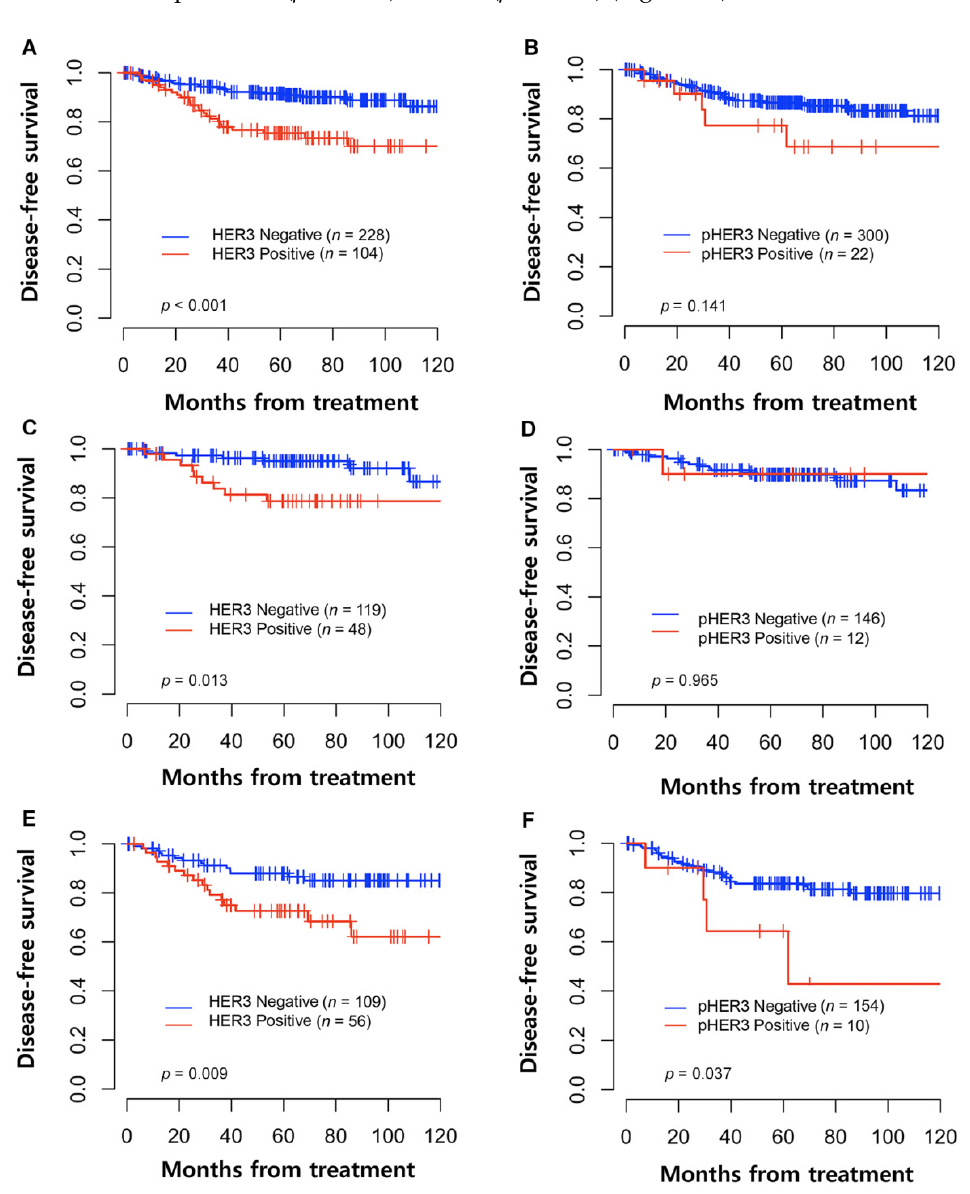
Figure 2. Kaplan–Meier graph illustrating disease-free survival (DFS) according to HER3 and pHER3 expression in patients with cervical cancer. ( A ) DFS according to HER3 expression in total patients, ( B ) DFS according to pHER3 expression in total patients, ( C ) DFS according to HER3 expression in patients without adjuvant treatment, ( D ) DFS according to pHER3 expression in patients without adjuvant treatment, ( E ) DFS according to HER3 expression in patients with adjuvant radiotherapy with or without concurrent chemotherapy, ( F ) DFS according to pHER3 expression in patients with adjuvant radiotherapy with or without concurrent chemotherapy.